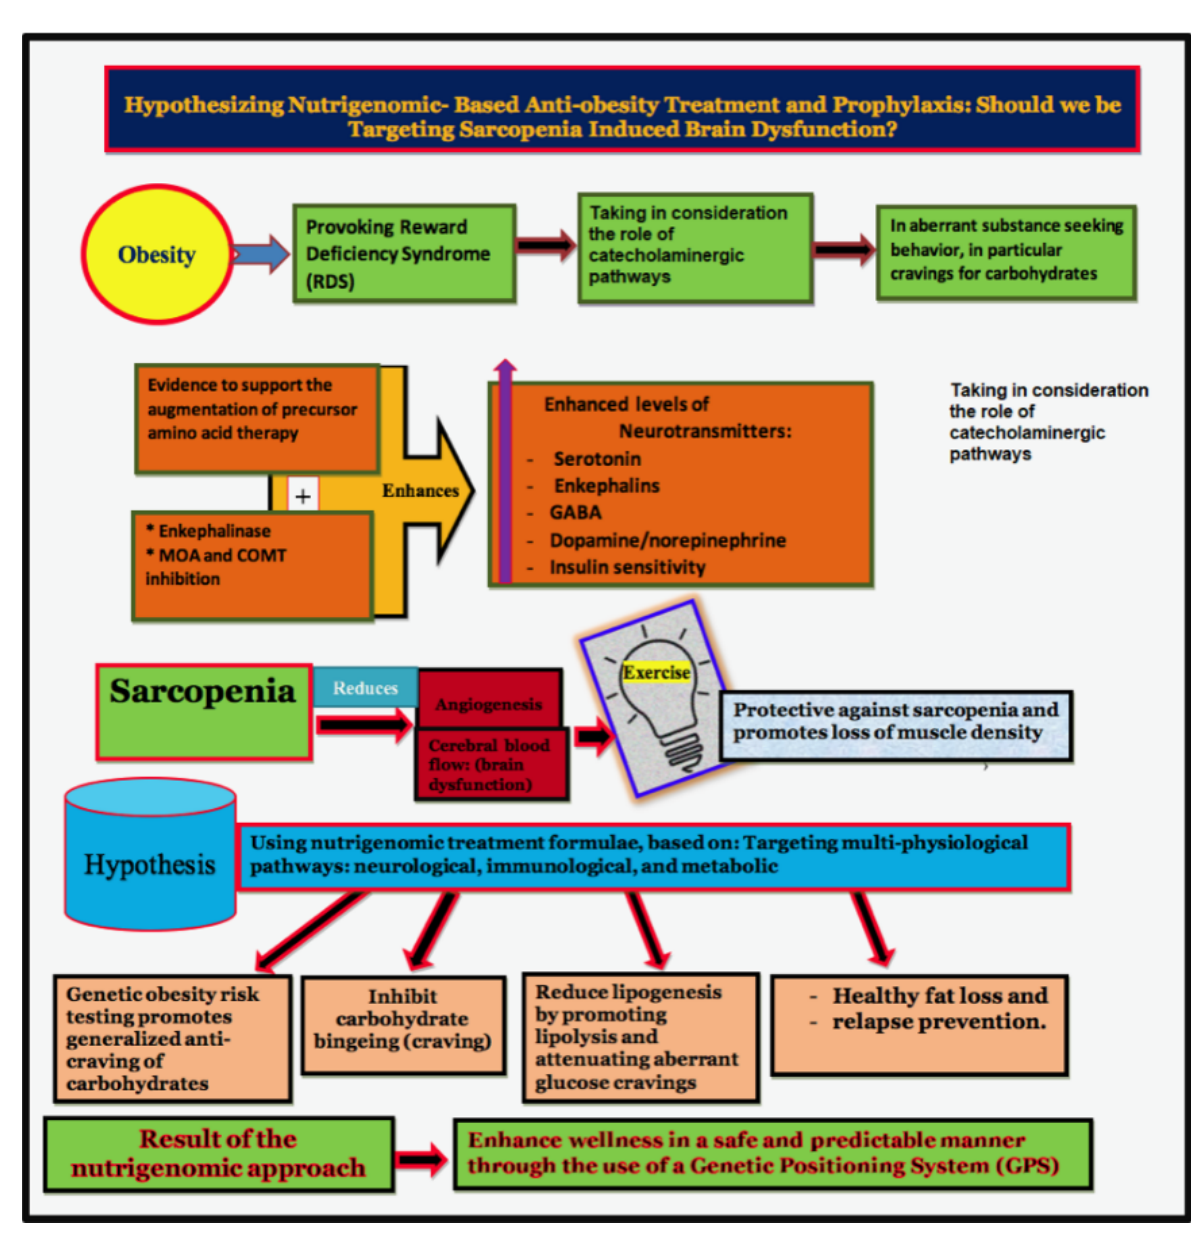
Figure 6. Hypothesizing nutrigenomic-based anti-obesity treatment and prophylaxis: should we be targeting sarcopenia- induced brain dysfunction?